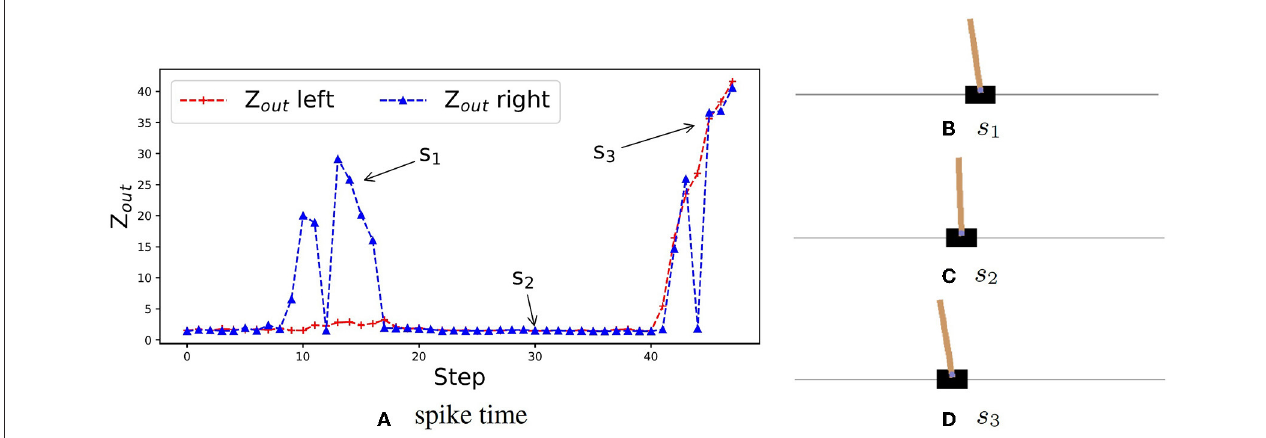
FIGURE 1 | Spike time variation of the output layer of CVTC. (A) An example of spike time in an episode shows the neurons’ spike time for moving left and right of each step. (B) States of the car at step s 1 . The car is at the center of the field, and the pendulum is turning left. The spike time for moving right is high. (C) States of the car at step s 2 . The car is at the center of the field, and the pendulum is upright. The spike times are both low. (D) States of the car at step s 3 . The car is on the left of the field, and the pendulum is turning left. The spike times are both